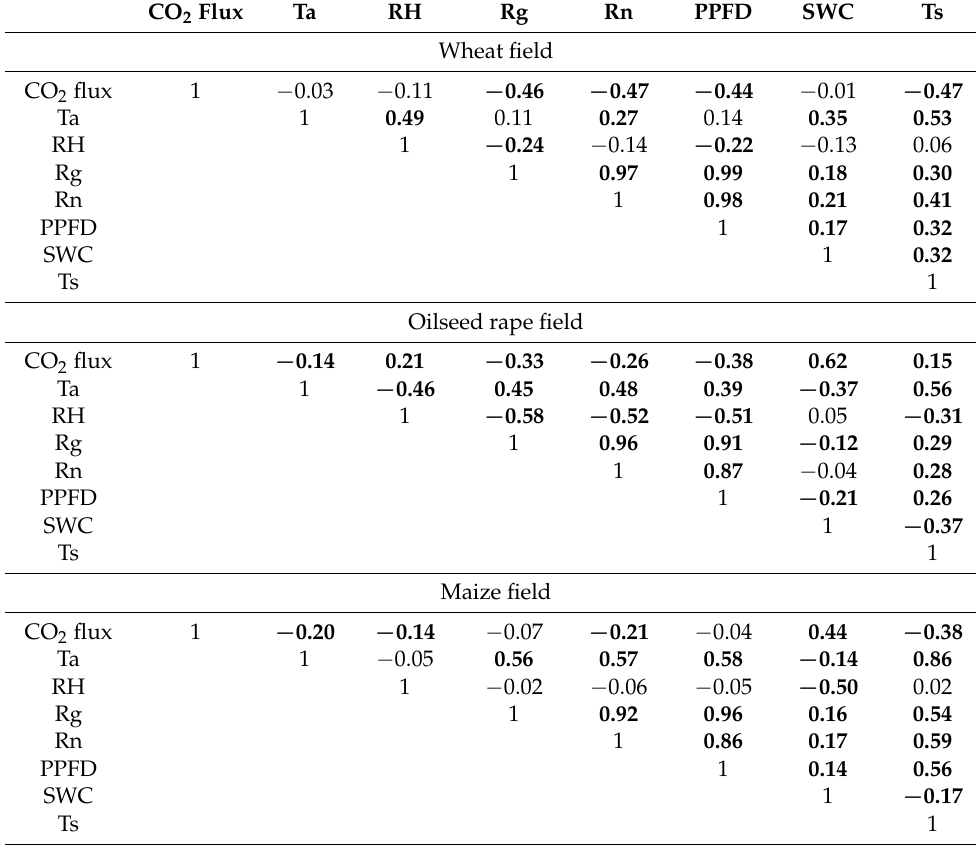
Table 3. Correlation between CO 2 fluxes and microclimatic conditions in the studied